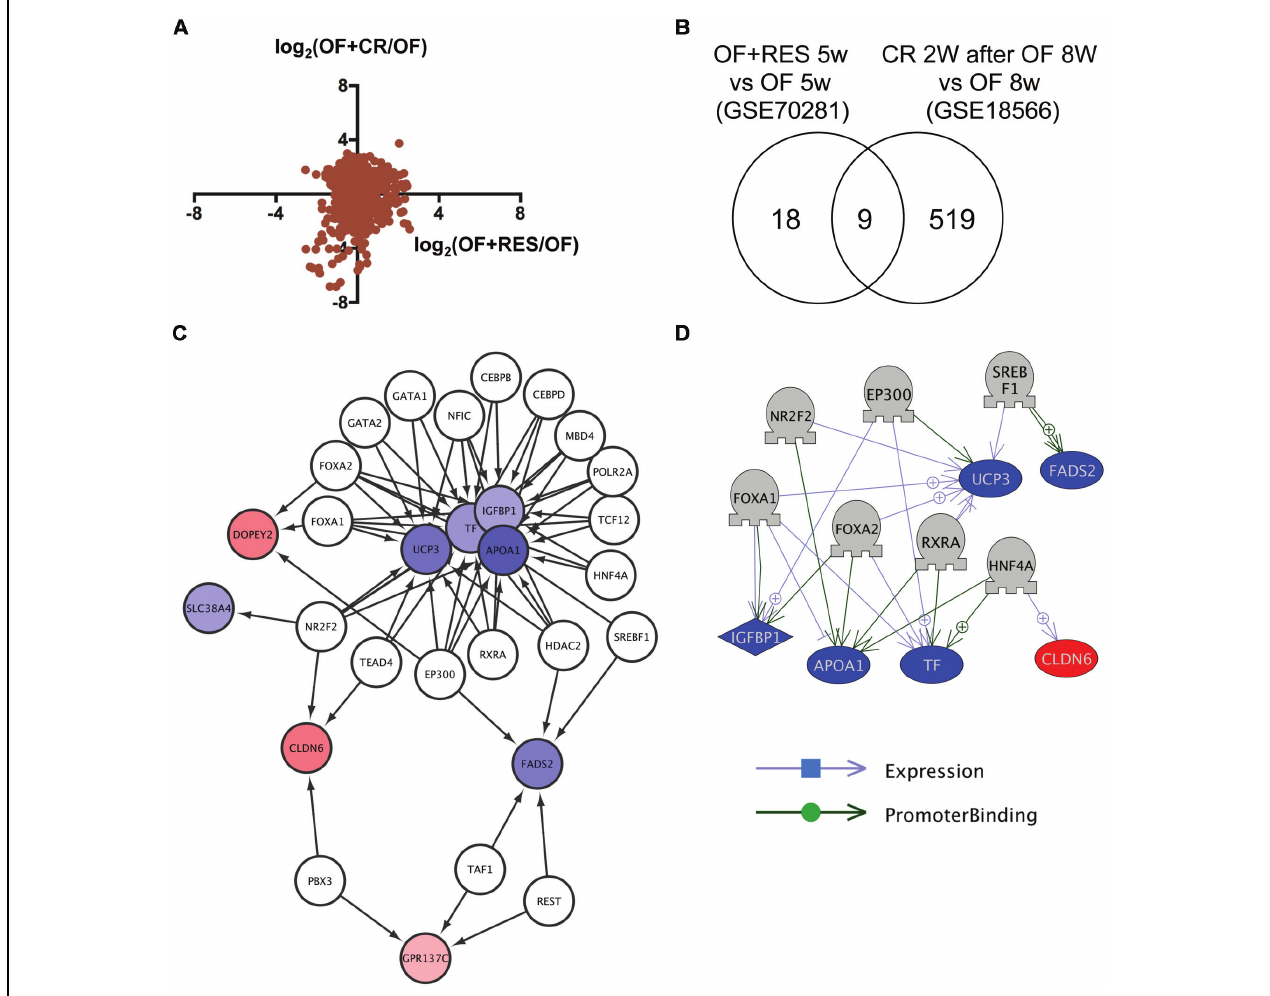
FIGURE 1 | Identification of transcriptional regulators for genes with changed expression levels common to RSV and CR in DIO zebrafish. (A) Correlation of gene expression changes induced by RSV and CR in DIO zebrafish. (B) Venn diagram of the numbers of DEG by RSV and CR in DIO zebrafish. (C) A regulatory network identified by iRegulon for the nine genes common between the RSV and CR groups. Genes shown in blue and red are decreased and increased, respectively, by RSV or CR. (D) A regulatory network identified by Pathway Studio for seven regulators and their six target genes. Genes shown in blue and red indicate decreased and increased expression, respectively, by RSV or